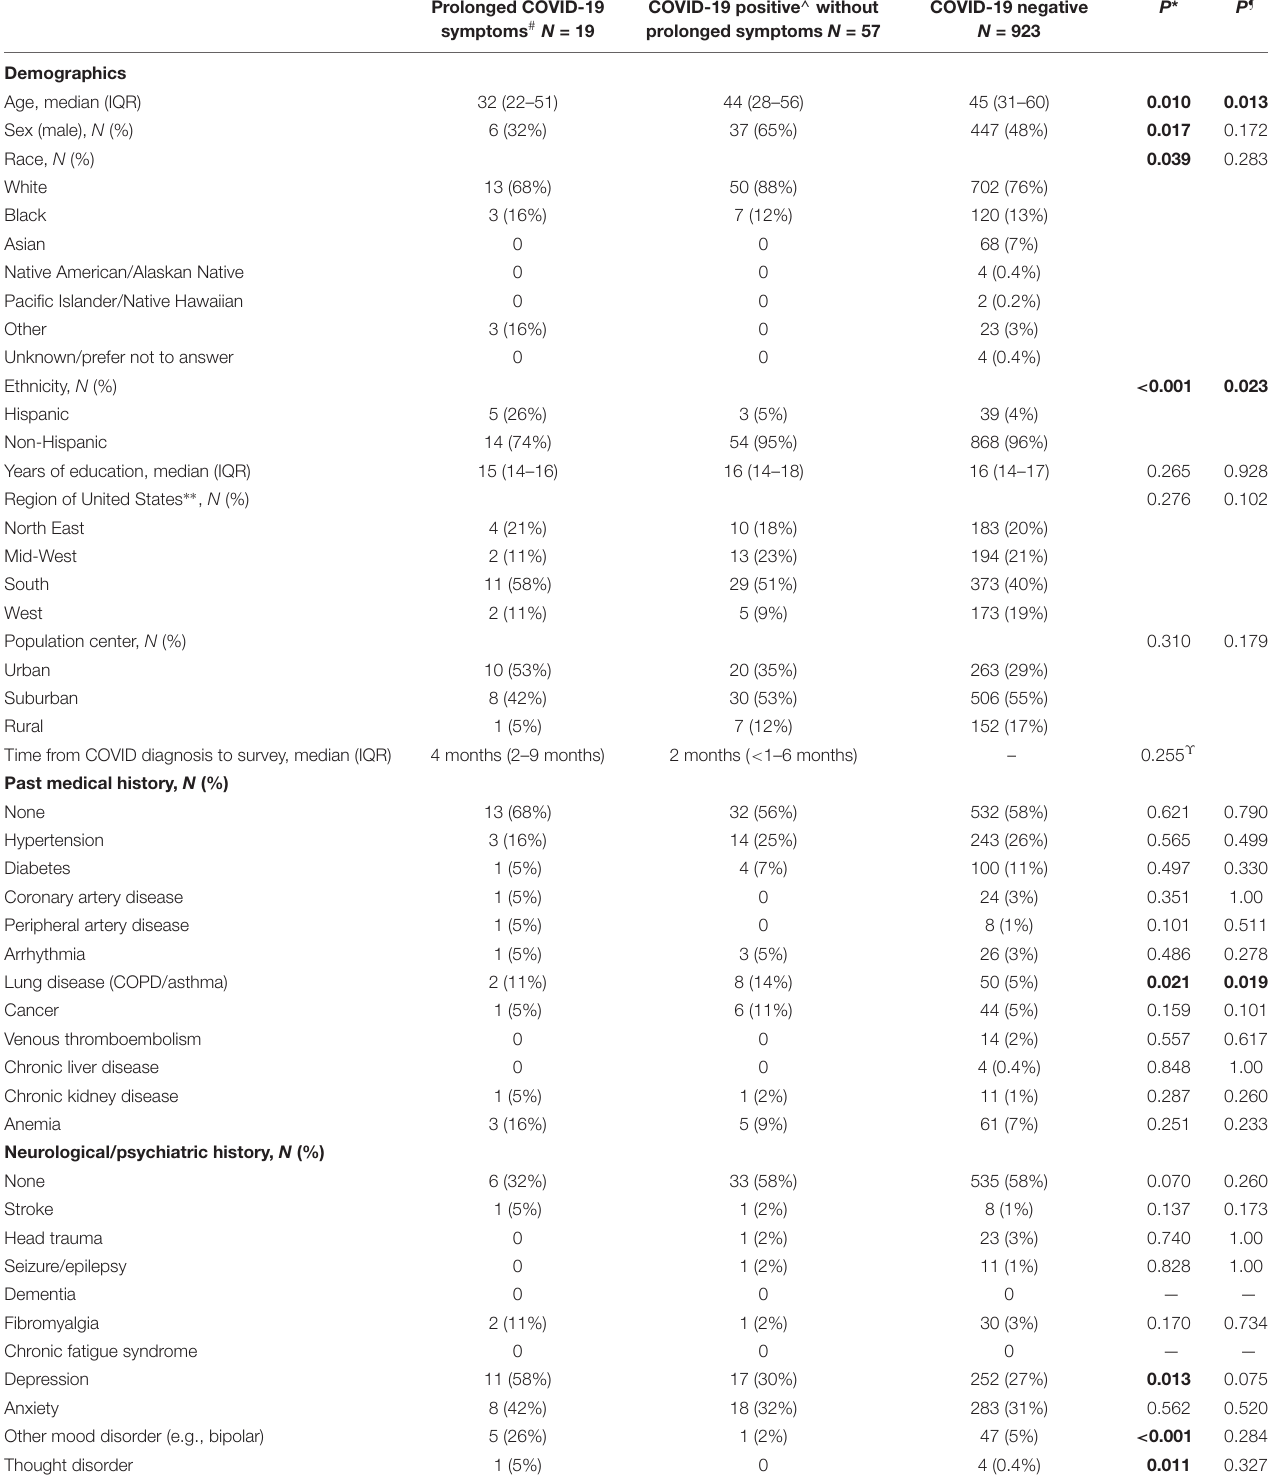
TABLE 2 | Characteristics of survey participants ( N =